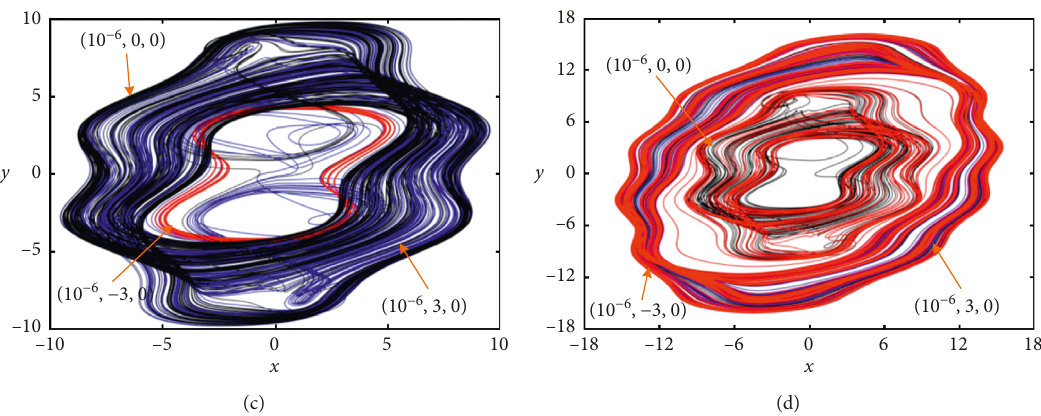
Figure 8: Phase plots of coexisting attractors in the x - y plane for different values of the parameter k . (a) Period-4 limit cycle coexisted with a pair of symmetric points at k 3. (b) Large-size period-1 limit cycle coexisted with a pair of symmetric period-3 limit cycles at (cid:31) k 4.5. (c) Chaotic attractor coexisted with period-5 limit cycle at k 7. (d) Coexisting chaotic attractors with two topologies at k (cid:31) (cid:31)